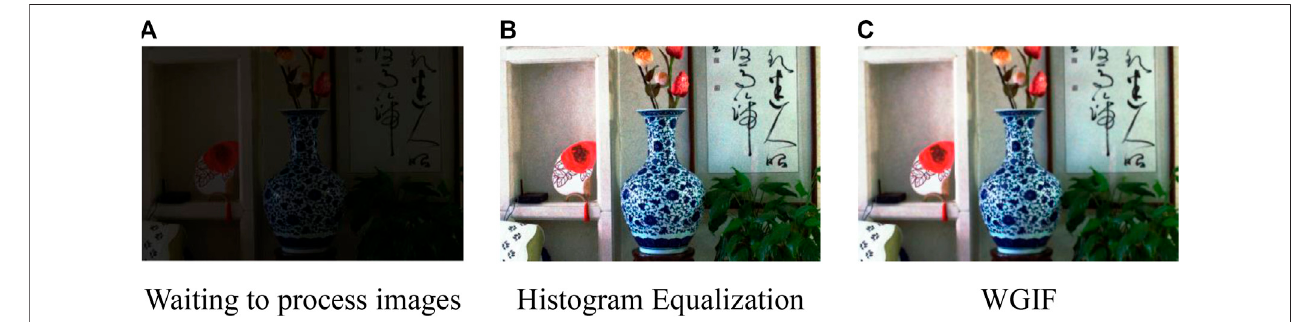
FIGURE 4 | The results of main feature layer obtains. (A) Waiting to process images (B) Histogram Equalization (C)